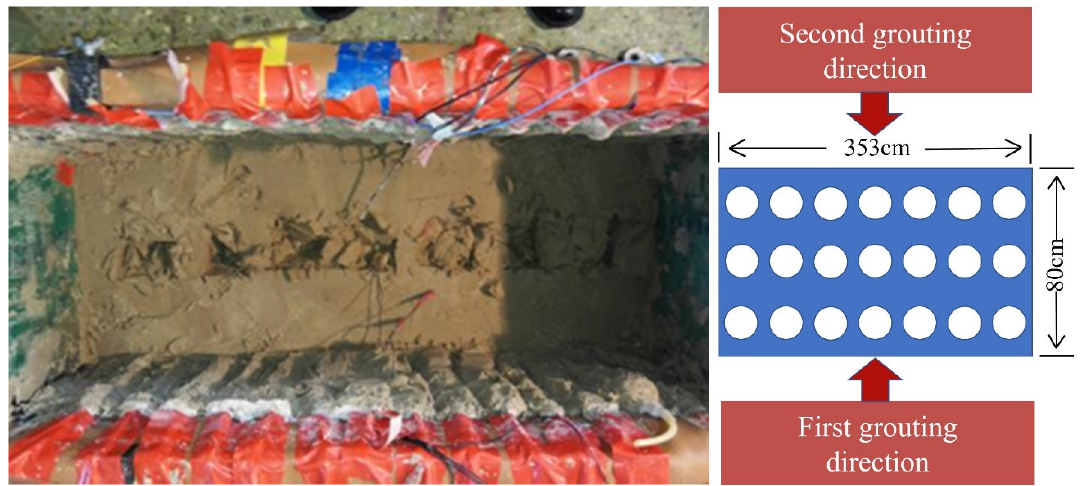
Figure 8. Schematic of the grid sampling method.